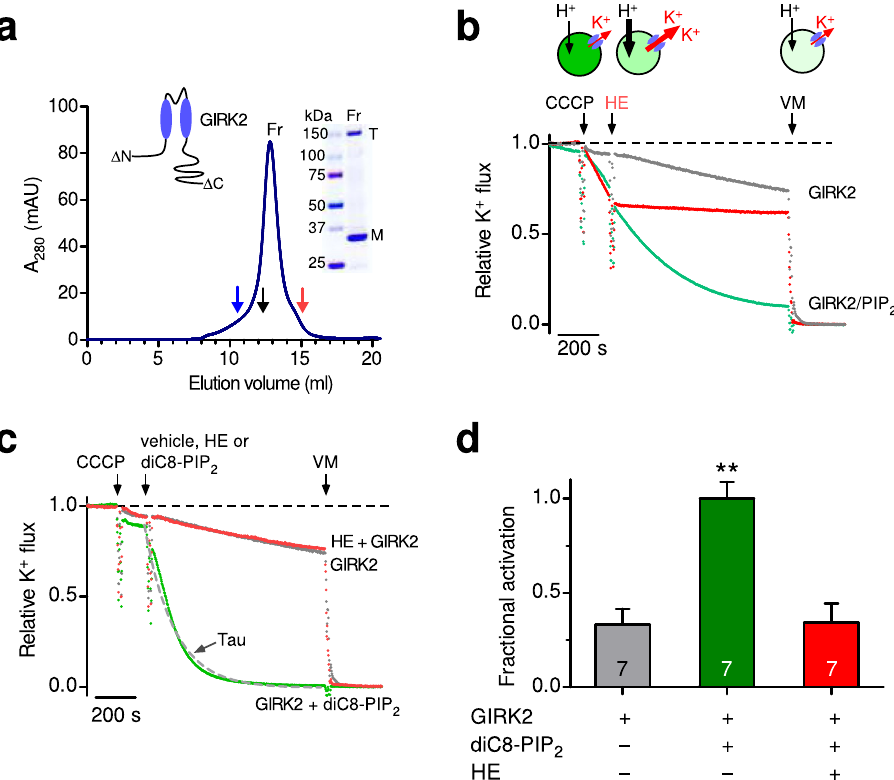
Figure 1. Brain PIP 2 and soluble PIP 2 activate reconstituted brain GIRK2 channels in the absence of other proteins. ( a ) Graph shows purification of mouse GIRK2 from Pichia pastoris . The absorbance is plotted as a function of elution volume, with molecular weight (MW) standards; Blue - 440 kDa, Black - 158 kDa, Red - 75 kDa (arrows). The major peak elutes at a volume consistent with the size of a GIRK2 tetramer (T). Inset, Coomassie blue staining of a gradient SDS-PAGE protein gel shows two bands, one for tetramer (T) and one for monomer (M). Inset, wild-type GIRK2 was truncated at the amino- and carboxy-termini (see methods). (b) Example of K + flux assay with GIRK2 reconstituted into PE/PG liposomes in the absence or presence of brain PIP 2 (1%) (see methods). The fluorescence is normalized and plotted as a function of time (‘Relative K + flux’). Arrows indicate addition of the proton ionophore carbonyl cyanide m-chlorophenylhydrazone (CCCP), the GIRK2 channel blocker MTS-HE (HE, 100 μ M) and valinomycin (VM). Note the quenching of fluorescence for GIRK2 with PIP 2 (green) upon addition of CCCP, which is attenuated with addition of MTS-HE. Dashed line represents no flux. (c) Representative fluorescent traces of GIRK2 alone (grey), GIRK2 and MTS-HE (red), and GIRK2 with acute application of 30 μ M diC 8 -PIP 2 (green). The decay was fit with a single exponential to determine that rate constant (1/ τ , s -1 ). (d) Bar graph shows the average ( ± SEM) fractional activation with diC 8 - PIP 2 based on the change in steady-state fluorescence (green bar vs. grey bar). MTS-HE (red bar) significantly inhibits